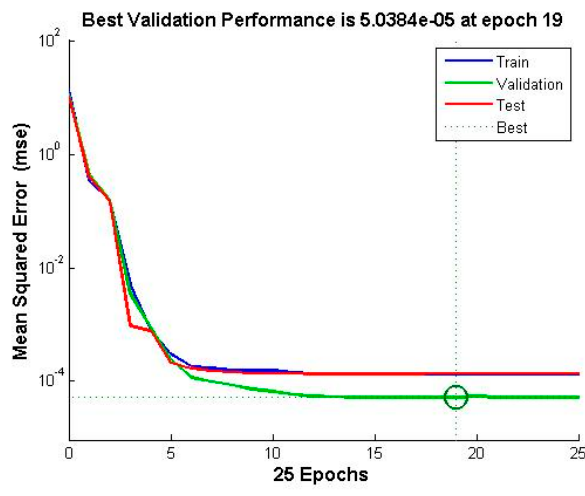
Figure 13. Fitting error rate curve of the BP artificial neural network and the BP artificial neural network based on genetic algorithms.